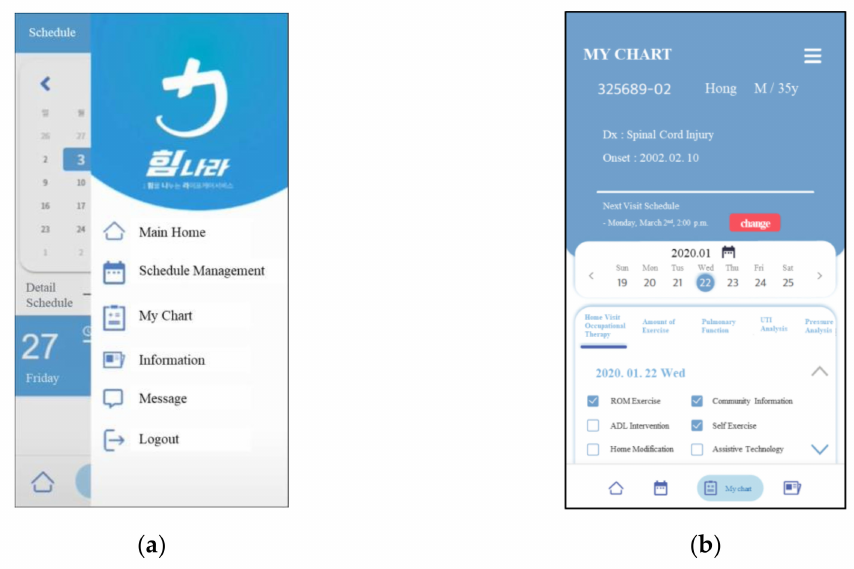
Figure 3. App (application) service of health care management: ( a ) The app is running and ( b ) the user can verify all of the scheduled